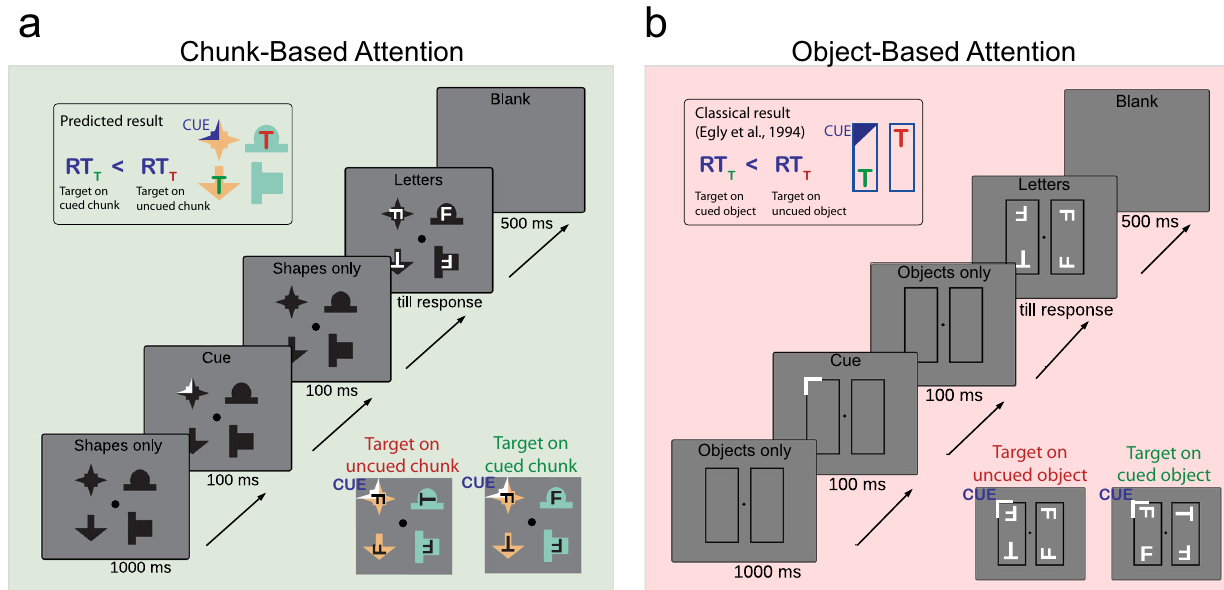
Fig. 3 The stimuli, the tasks, and the trial structures in Experiment 2. a Chunk-based attention paradigm. b Object-based attention paradigm. a , b Top- left insets display the expected results in the two paradigms (longer RTs when the target appears on the uncued chunk/object vs. cued chunk/object). Bottom-right insets in a , b present two examples of trials, in which the target (T) appeared on the cued (green label) and on the uncued (red label) chunks/ objects. The design, the visual statistical learning, and the Familiarity test were identical to Exp. 1 (Fig. 1). The shapes and the letters are magni fi ed in the fi gure compared to the actual experimental